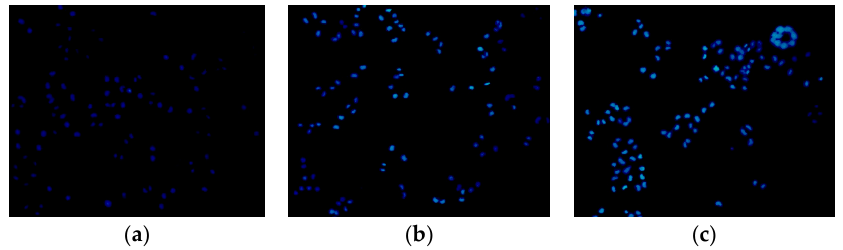
Figure 3. Hoechst 33342 staining of compound 4u in Hela cells. ( a ) Cells that were not treated with